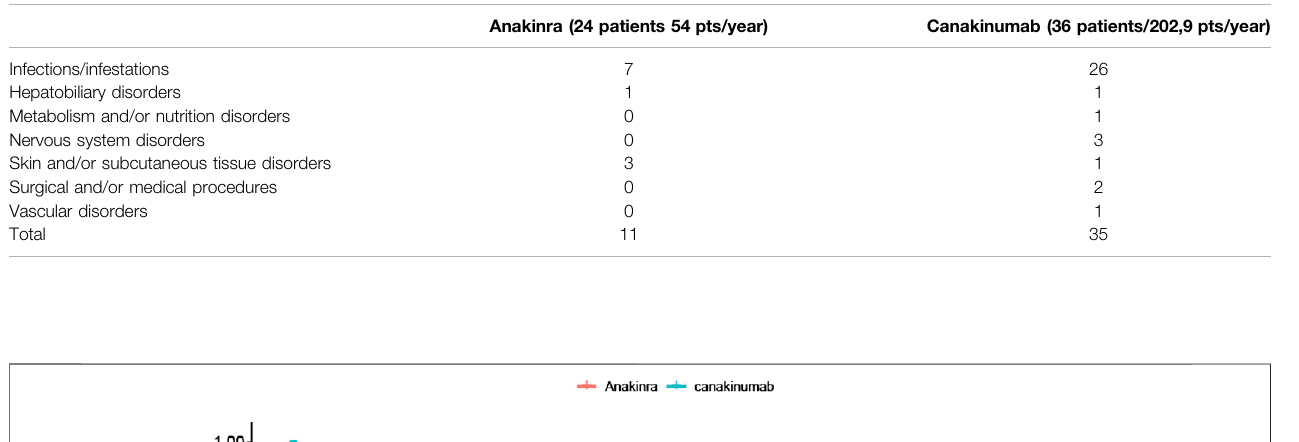
FIGURE 2 | Drug survival curves for anakinra (red line) and canakinumab (blue line). The retention rate for canakinumab was signi fi cantly higher than for anakinra. Time expressed in months.